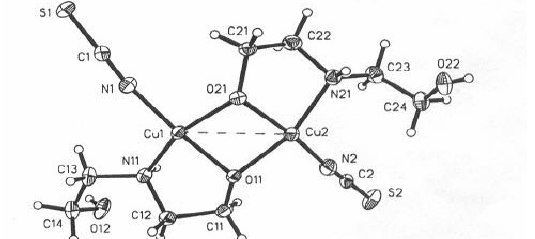
Figure 5. Molecular structure of [Cu The displacement ellipsoids are drawn at the 50% propability level and H atoms are shown as small circles of arbitrary radii 21